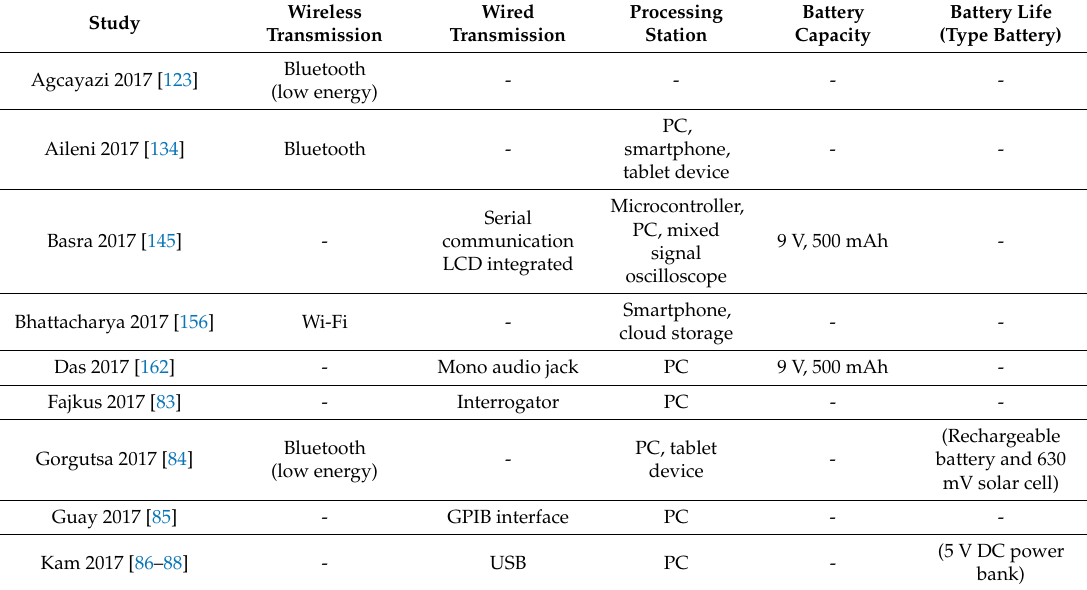
Table A3. Analysis of transmission technology, processing station, and energy autonomy for studies in the wearable category published before